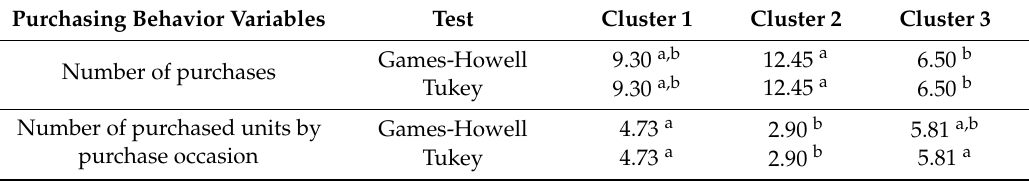
Table 6. Games–Howell and Tukey